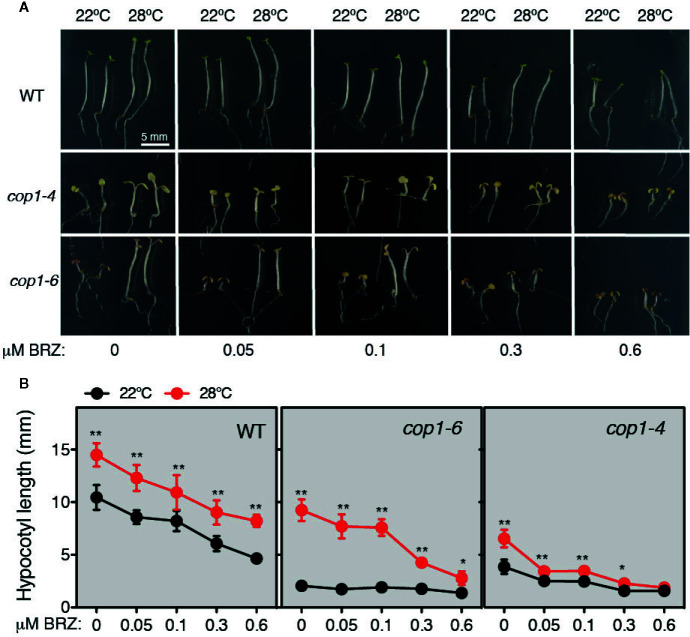
Thermo-induced hypocotyl elongation of cop1-6 seedlings is drastically reduced upon BRZ treatment. (A) Representative pictures of 5 days-old Col-0, cop1-6 and cop1-4 seedlings grown in the dark at 22°C/28°C, in the presence of increasing BRZ concentrations. (B) BRZ dose-response. Graphs showing the hypocotyl lengths of 5 days-old plants grown in constant darkness and 22°C or 28°C. Error bars indicate standard deviation. (n=15 -30). Statistical analysis was performed with a two- tailed Student’s t-test (*p < 0.05, **p < 0.001, 28°C compared with 22°C conditions).